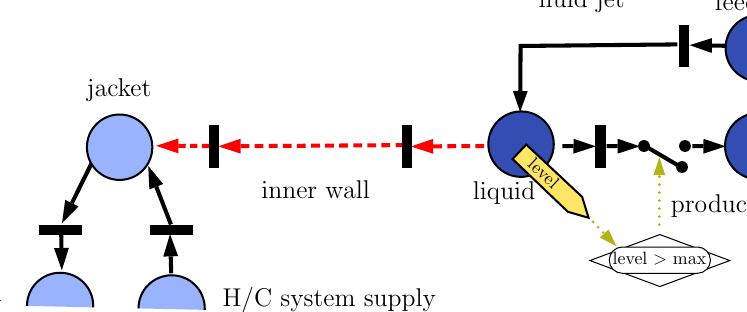
Figure 10. An even more simplified tank model. The outer wall is neglected and jacket, and the contents are